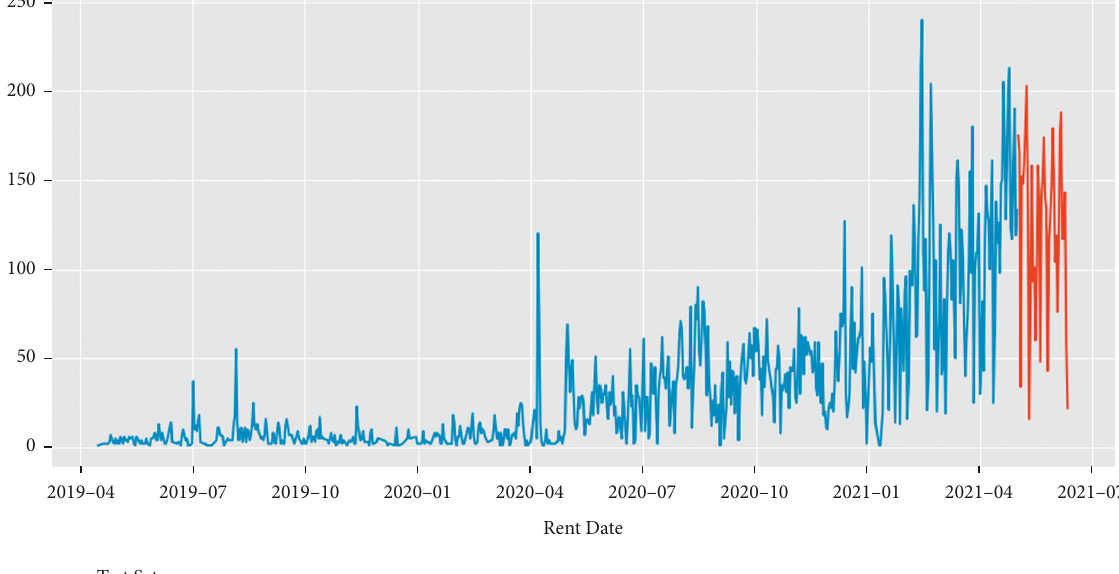
Figure 10: Training and testing data distribution.